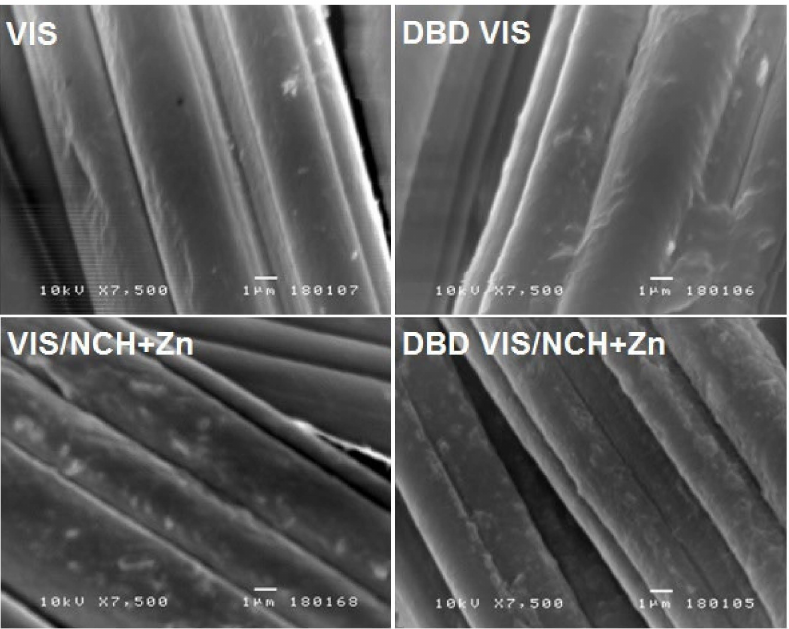
Figure 5. SEM images of unmodified and DBD-modified viscose fabrics before and after functional- ization with NCH+Zn.